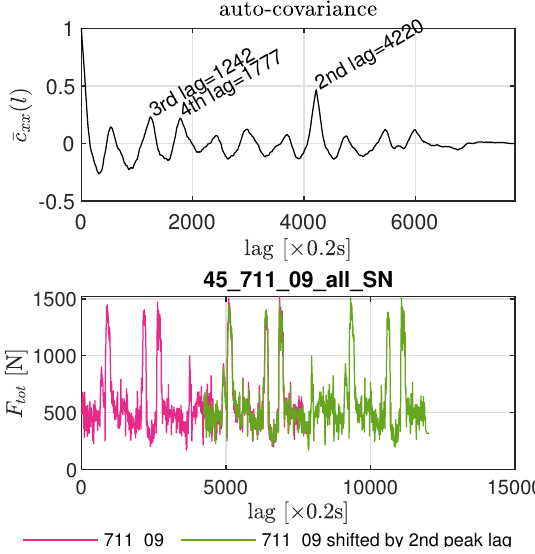
Figure 5: Upper plot normalised auto-correlation with 2nd to 4th peak identified. Bottom plot signal overlaid with shifted signal by 2nd peak’s lag. Signal name indicated in the title of bottom